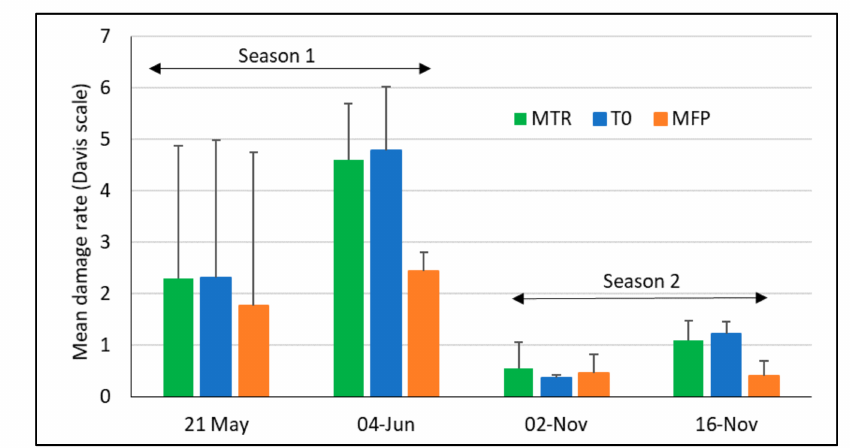
Figure 5. Mean plant damage (+SD) assessed on the Davis scale, during the two maize growing seasons in Ghana in 2020. MTR = T. remus release plots; T0 = plots without T. remus releases, no pest control; MFP = farmers’ conventional practice incl. chemical pest control; 4 replicates per treatment and season.